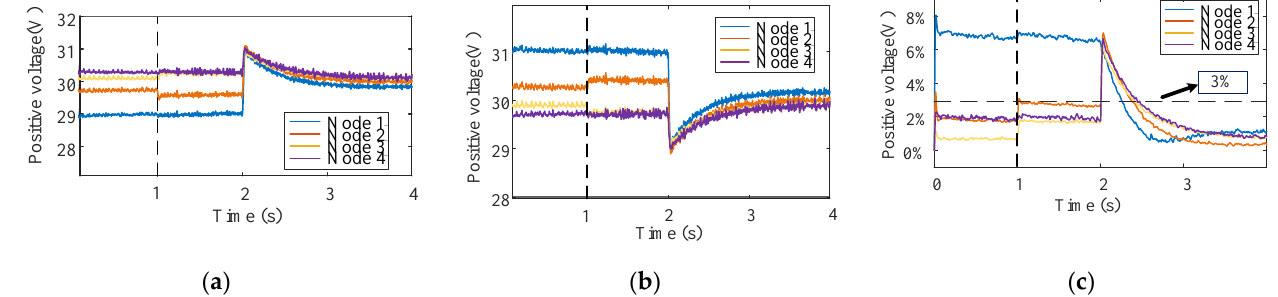
Figure 13. The sum of power losses of the neutral line.